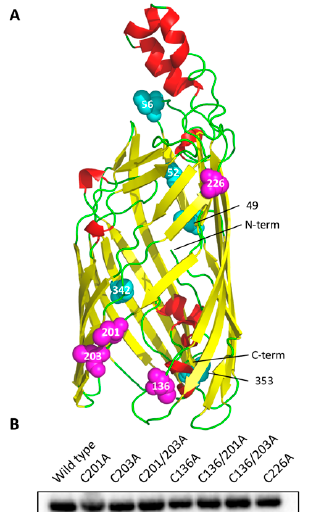
Figure 1. ( A ) C. pneumoniae major outer membrane protein (MOMP) homology model with cysteine residues highlighted. The four cysteines of interest (C136, C201, C203 and C226) are labelled and shown as magenta spheres with the remaining cysteines shown as cyan spheres. The N-terminus is located on a loop inside the barrel and the C-terminus (His-tagged) on a β -sheet on the periplasmic side of the membrane. ( B ) Western blot of cysteine-mutated recombinant MOMP (rMOMP) expressed in E. coli outer membranes. Protein was detected using a 6 × His epitope tag monoclonal mouse IgG primary antibody and an anti-mouse IgG (H + L)-HRP-conjugated secondary antibody.